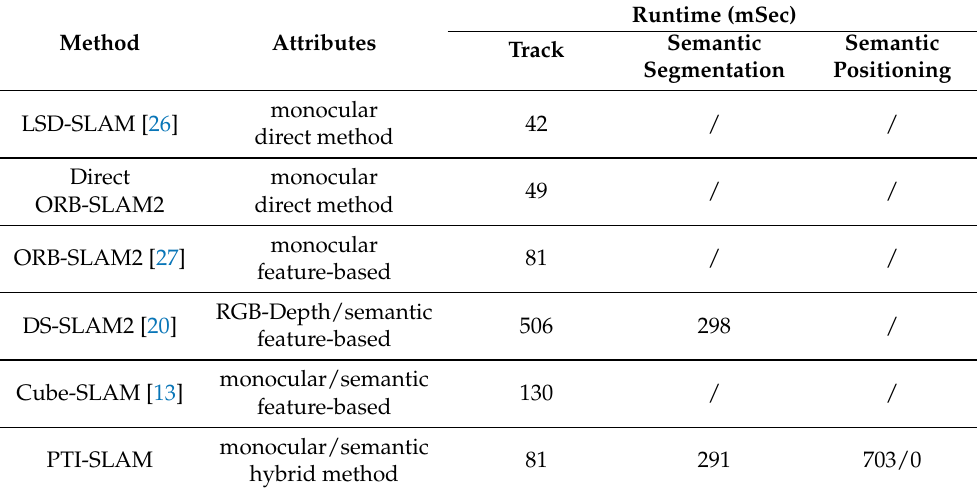
Table 8. Time consumption comparison of different algorithms.